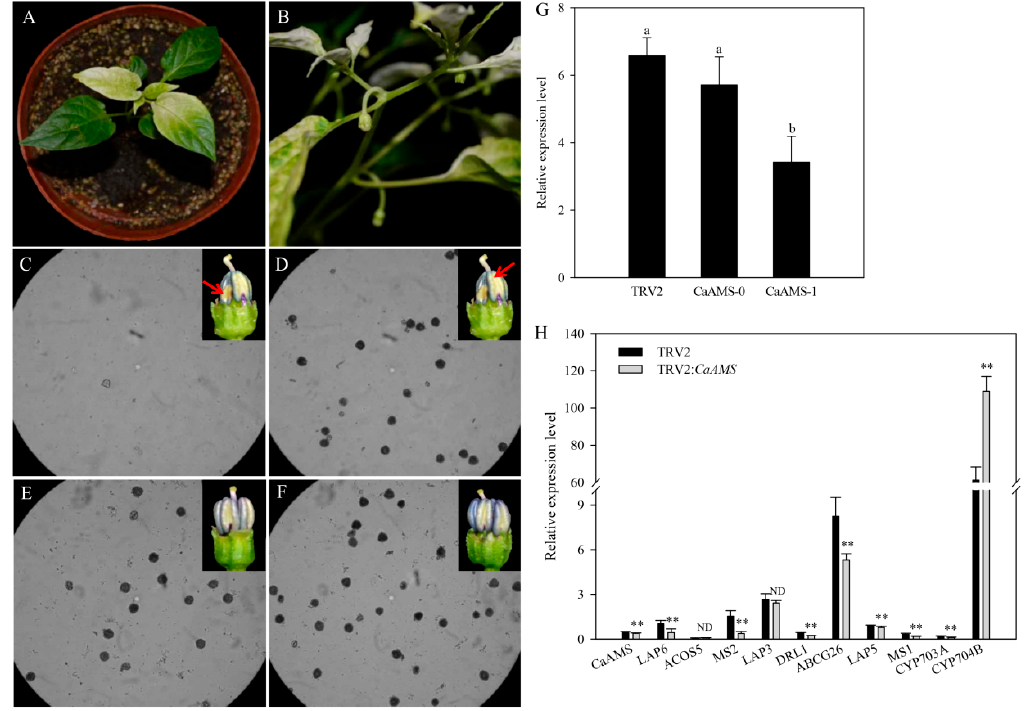
Figure 3. Effects of silencing CaAMS in pepper. ( A , B ) PDS-silenced plants (negative controls). ( C – E ) CaAMS -silenced plants. ( C ) Pollen grains in defective stamens of CaAMS-1 type flower buds. ( D ) Pollen grains in normal stamens of CaAMS -1 type flower buds. ( E ) Pollen grains in stamens